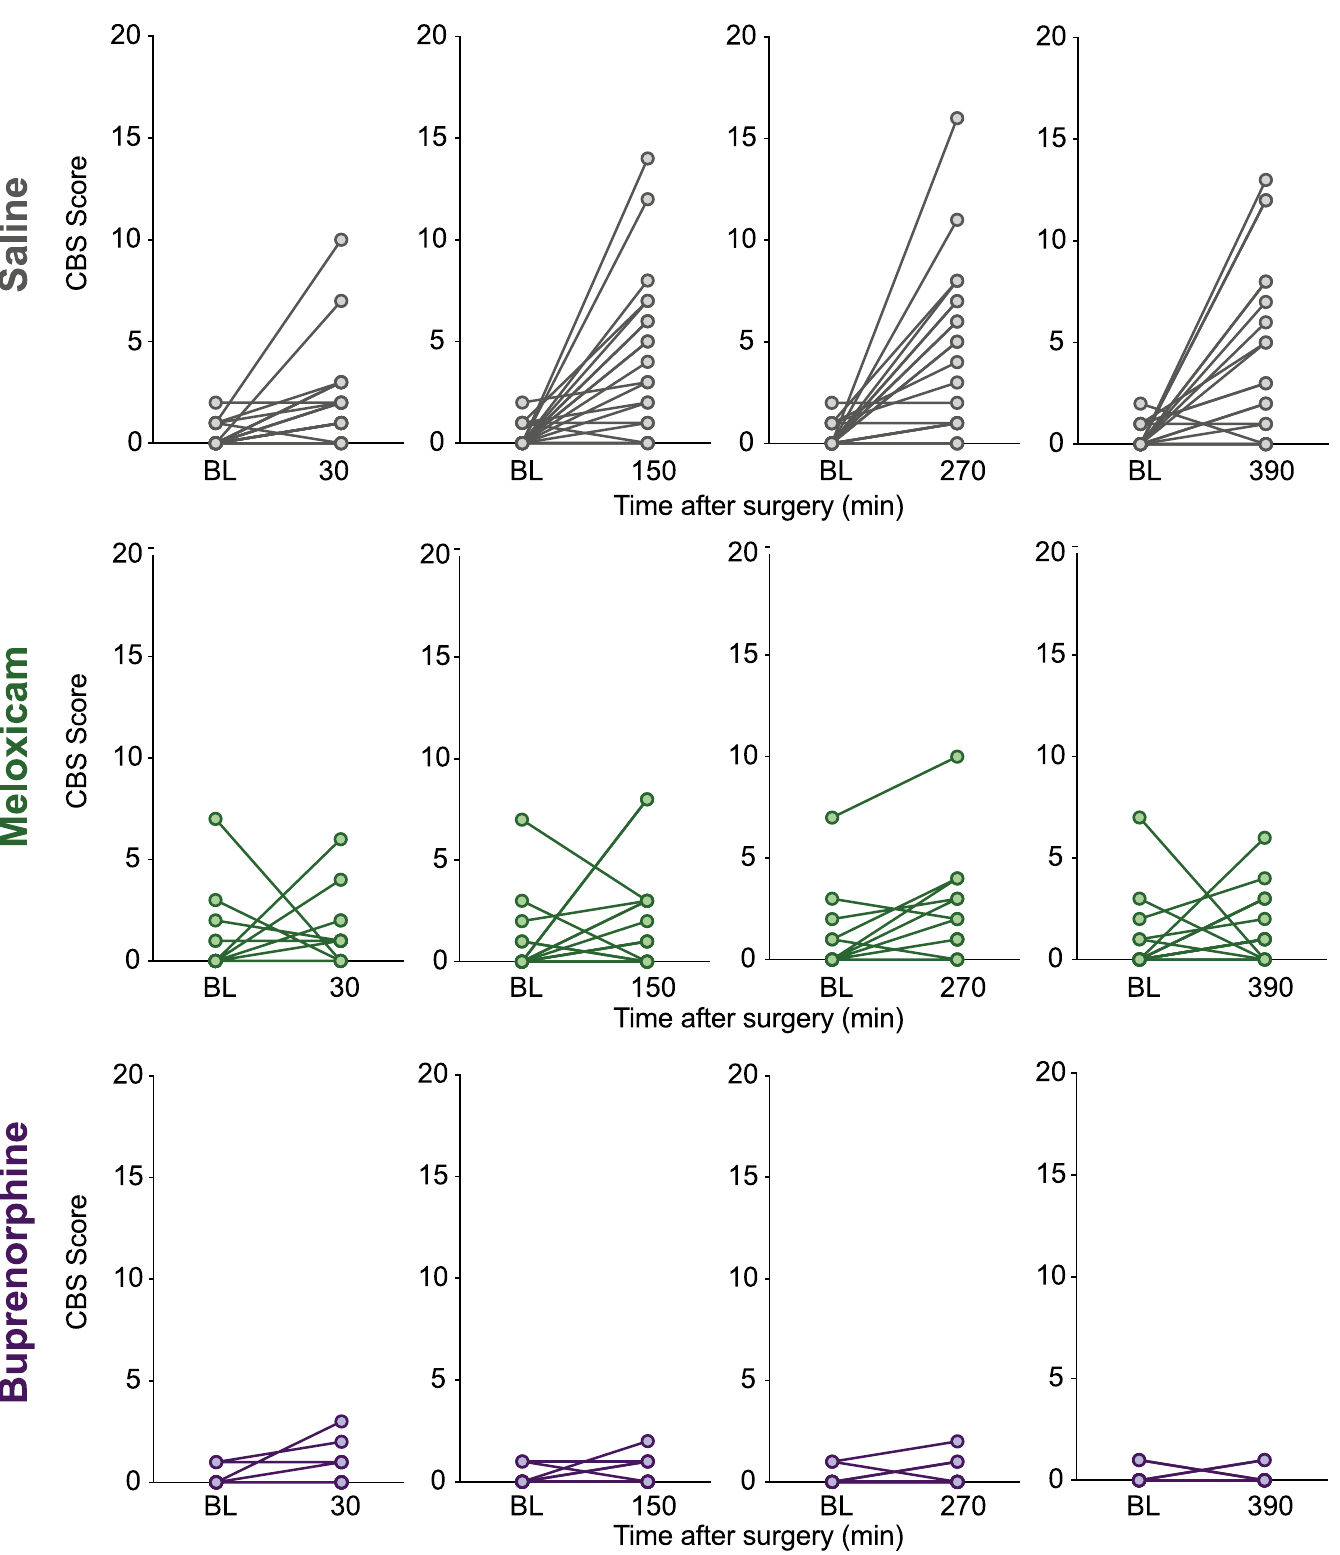
Fig 4. CBS scores of individual rats at all post-surgical timepoints in comparison to their baseline scores. Saline (n = 21), meloxicam (n = 16) and buprenorphine (n = 15) rats at all time points.